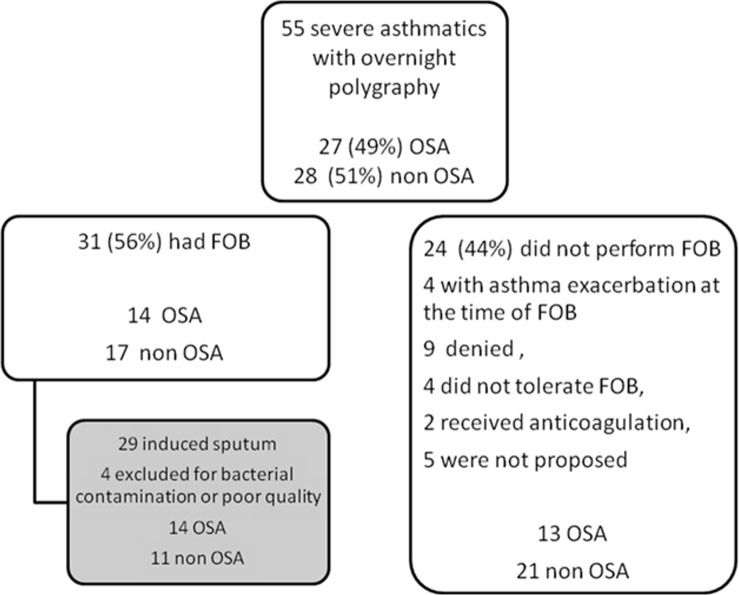
Flow of participants through the study.FOB: fibre optic bronchoscopy.